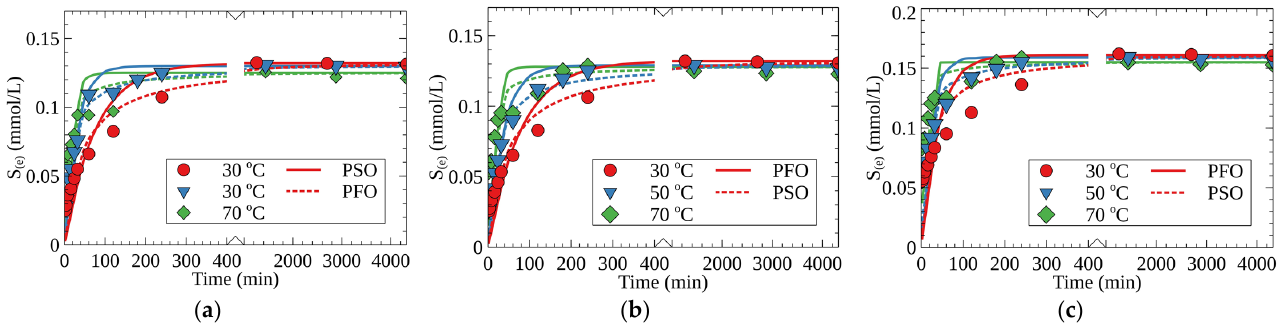
Figure 4. Kinetic curves of Cs-133 adsorption at different temperatures: ( a ) RFR-i, ( b ) RFR-Ca and ( c ) RFR-T; pH-11 (NaOH), V/m—500 mL/g: dots—experimental data, lines—fits with pseudo-first- order (PFO) and pseudo-second-order (PSO) kinetic models.